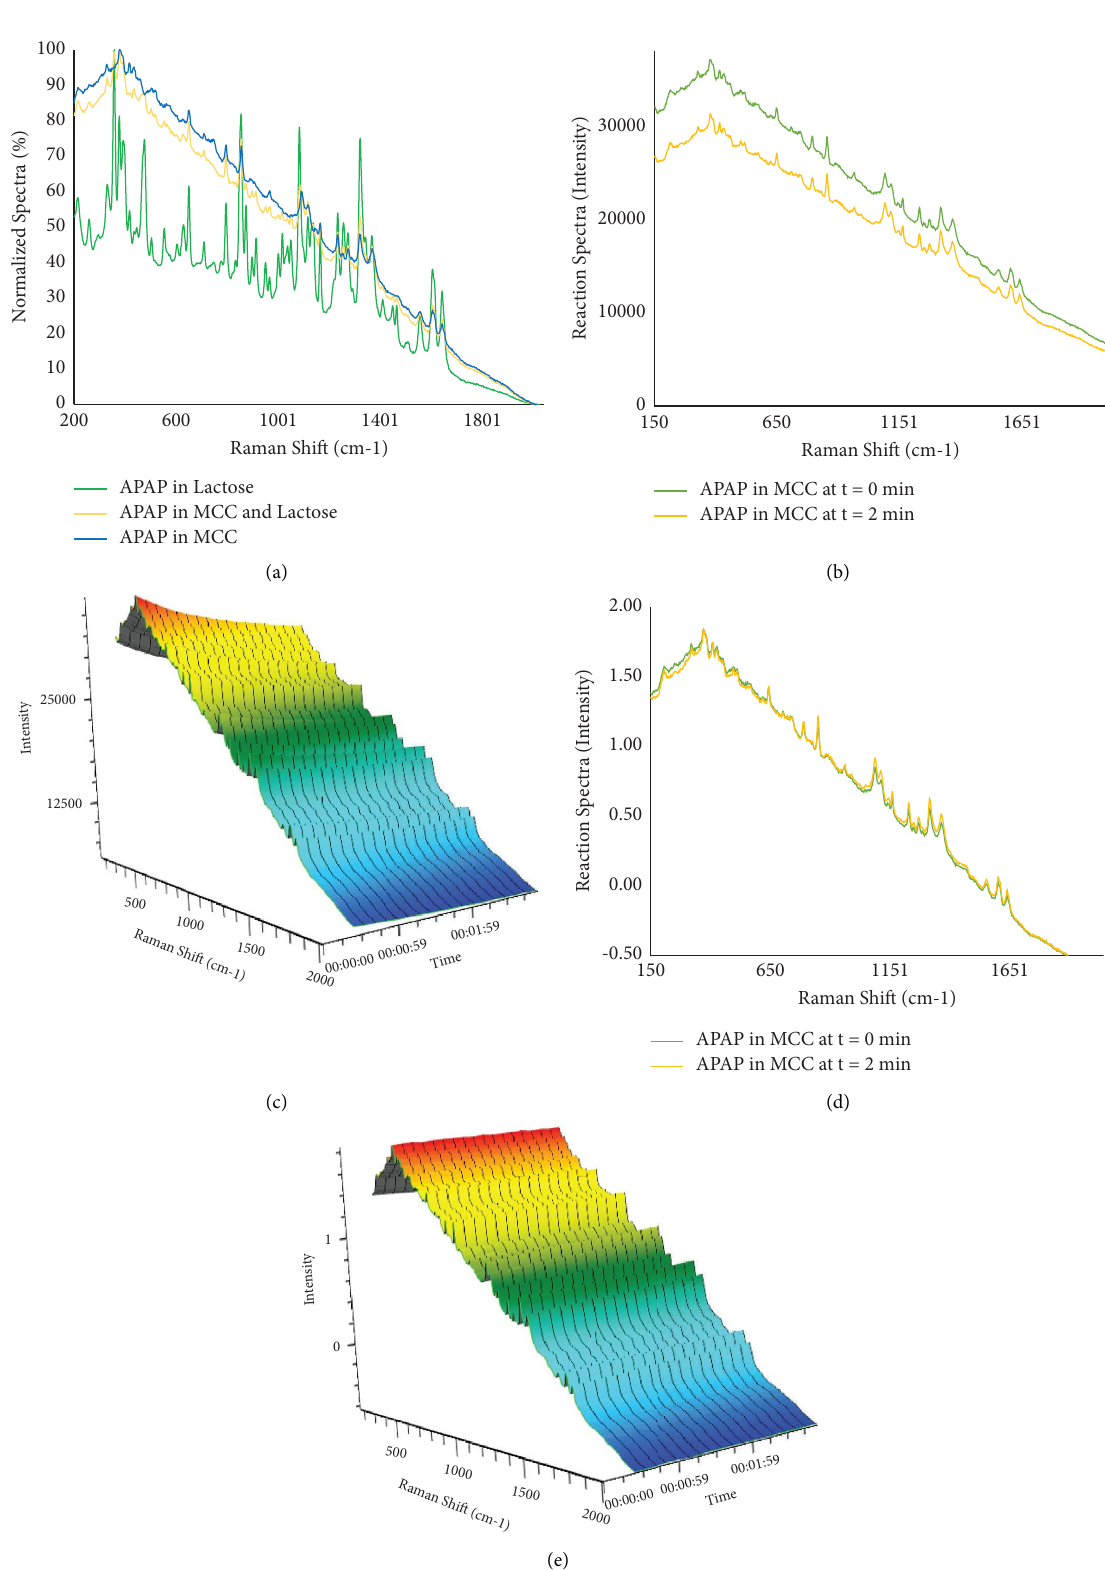
Figure 4: (a) Raman spectra of 10% APAP in only lactose (green), only MCC (blue) and in the mixture of MCC and lactose (yellow), (b) Raman spectra of 10% APAP in MCC at t � 0minutes and t � 2minutes, (c) surface plot of Raman spectra of 10% APAP in MCC showing bleaching over time, (d) Raman spectra of 10% APAP in MCC at t � 0 minutes and t � 2minutes after SNV correction, and (e) surface plot of Raman spectra of 10% APAP in MCC after SNV